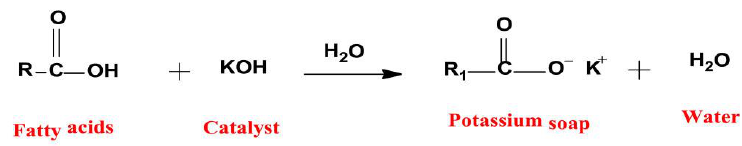
Figure 4. Hydrolysis reaction mechanism. Data adapted from [71], published by Elsevier, 2022.